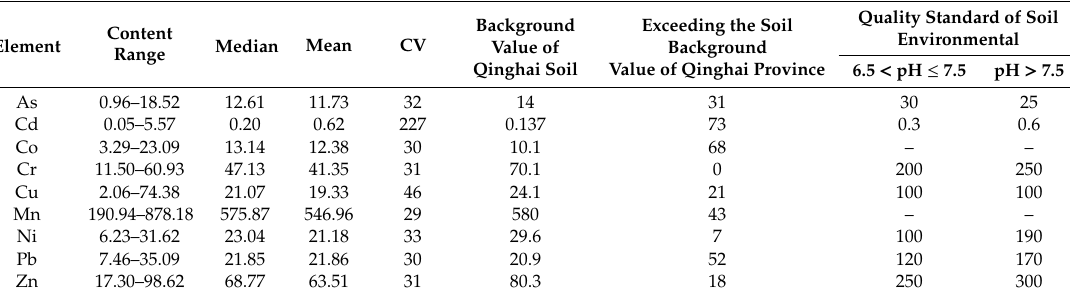
Table 6. Statistics of heavy metals in the surface soil in this